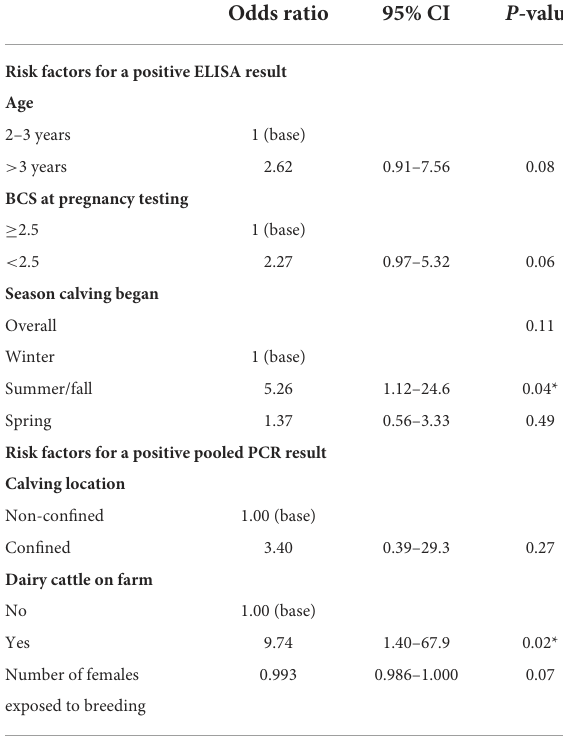
TABLE 9 Summary of animal level multivariable regression analysis examining associations between potential risk factors and testing outcomes for 3,171 individual beef cows accounting for clustering within 159 herds using generalized estimating equations.